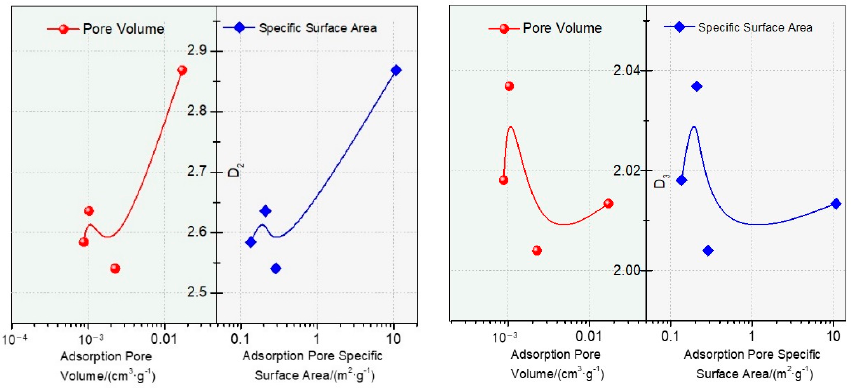
Figure 7. Relationships between structural parameters and fractal dimensions.